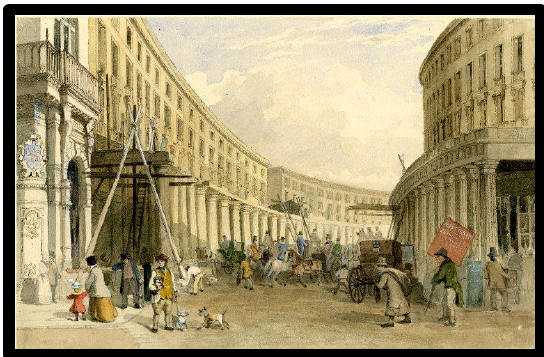
Figure 17: Archer, J.W. (1848) Deconstruction of the Quadrant. (URL